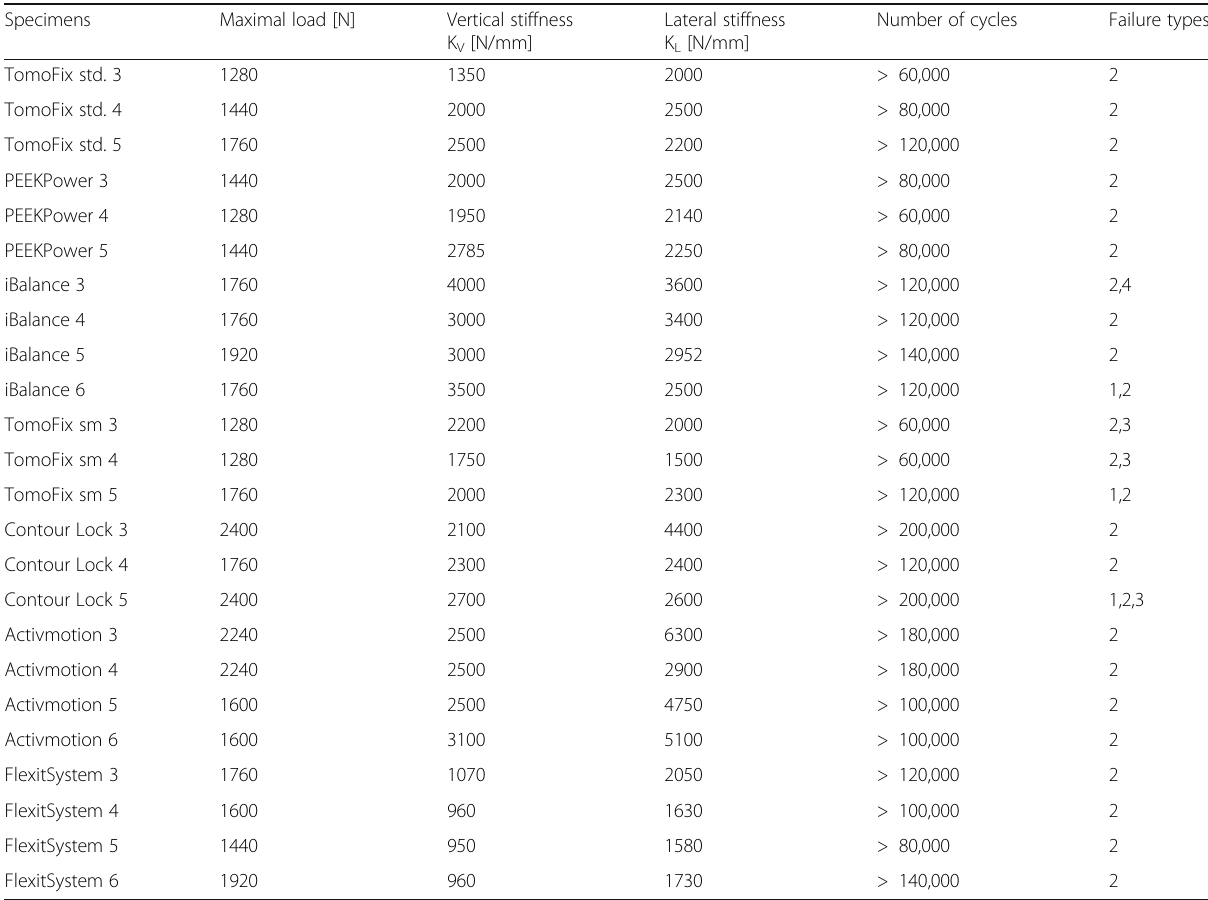
Table 7 Summary of fatigue failure tests